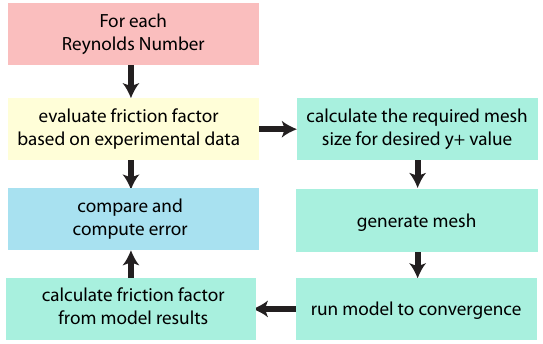
Figure 3: Flowchart of the numerical testing